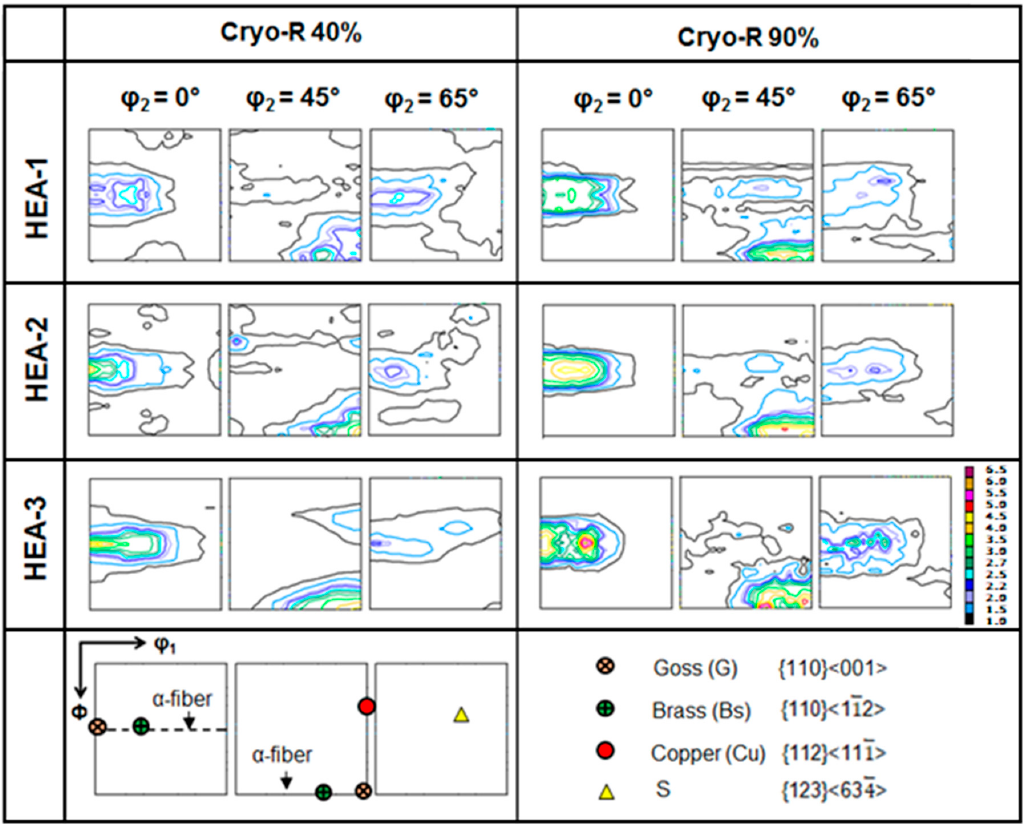
Figure 6. Texture of cryo-rolled (Cryo-R) HEAs 1–3 represented by ϕ 2 = 0 ◦ , 45 ◦ , and 65 ◦ ODF sections (intensities are given in multiples of a random distribution). Lower ODF sections give the position of the typical rolling components of FCC metals and alloys.